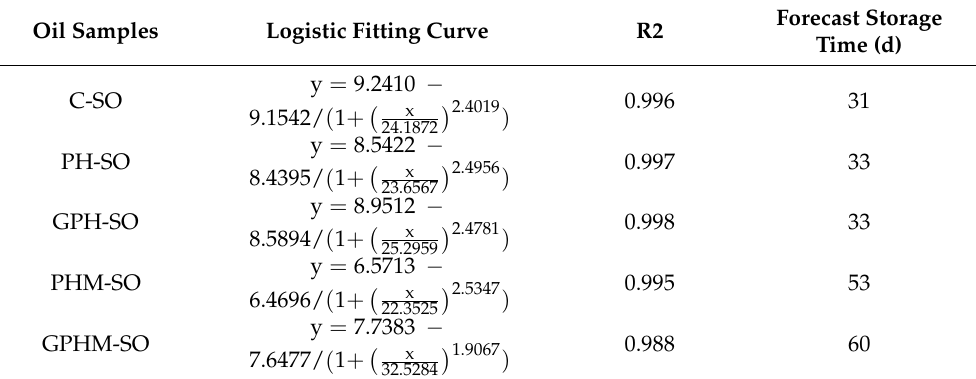
Table 6. Fitting equation between peroxide value (y) and storage time (x) during 60 ± 3 ◦ C accelerated